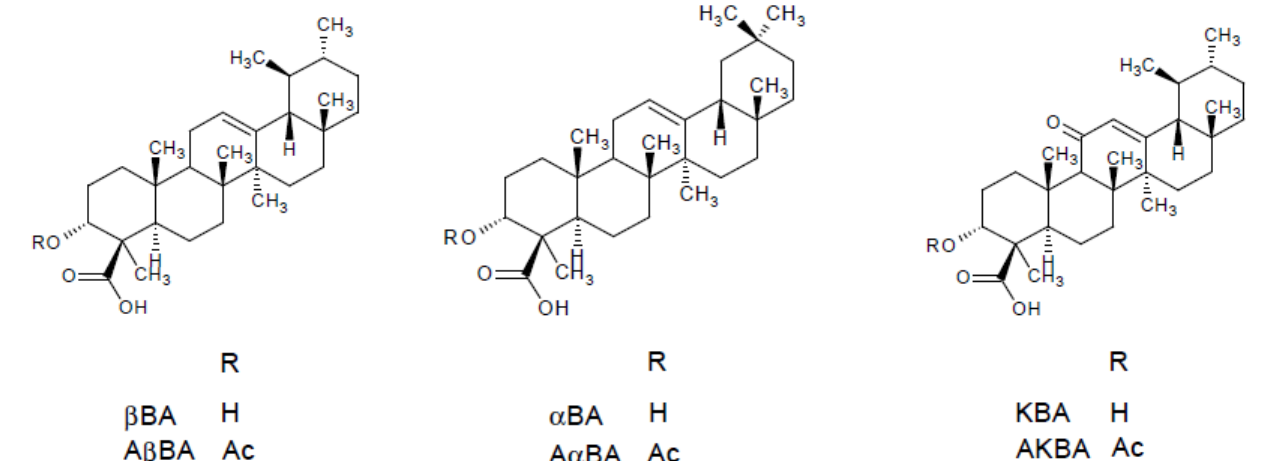
Figure 1. Chemical structures of the most relevant boswellic acids: β -boswellic acid ( β BA), α -boswellic acid ( α BA), 11-keto- β -boswellic acid (KBA), 3-O-acetyl- β -boswellic acid (A β BA), 3-O-acetyl- α -boswellic acid (A α BA), 3-O-acetyl-11- keto- β -boswellic acid